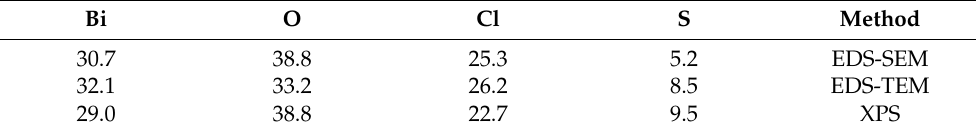
Figure 2. ( a ) TEM, ( b ) top-view HRTEM, ( c ) side-view HRTEM, ( d ) SAED of S-BiOCl, and ( e ) STEM-EDS elemental mapping of Bi, Cl, O, and S of S-BiOCl sheet (inset of ( e ) is STEM image of the corresponding area). Table 1. Elemental composition of S-BiOCl catalyst (at. %) by EDS-SEM, EDS-TEM, and XPS. Bi O